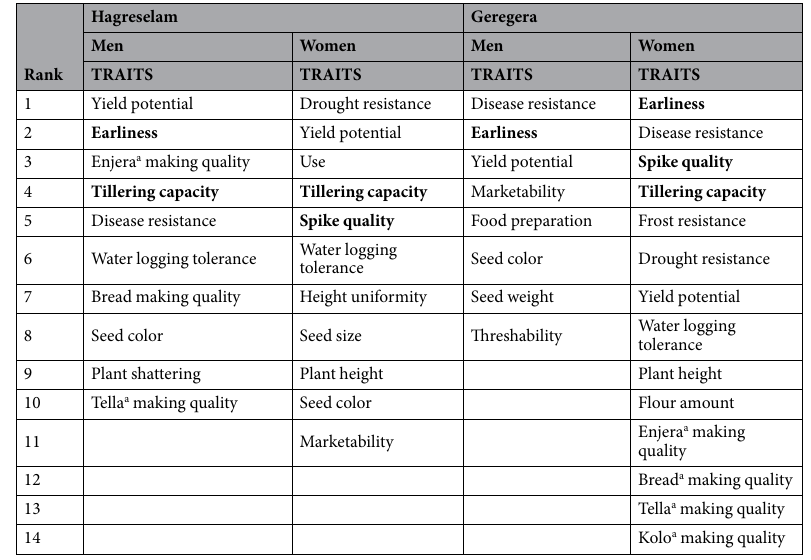
Table 1. Wheat traits identified by farmers in Hagreselam and Geregera during FGD, ordered by importance. The traits used for PE are in bold. a Local